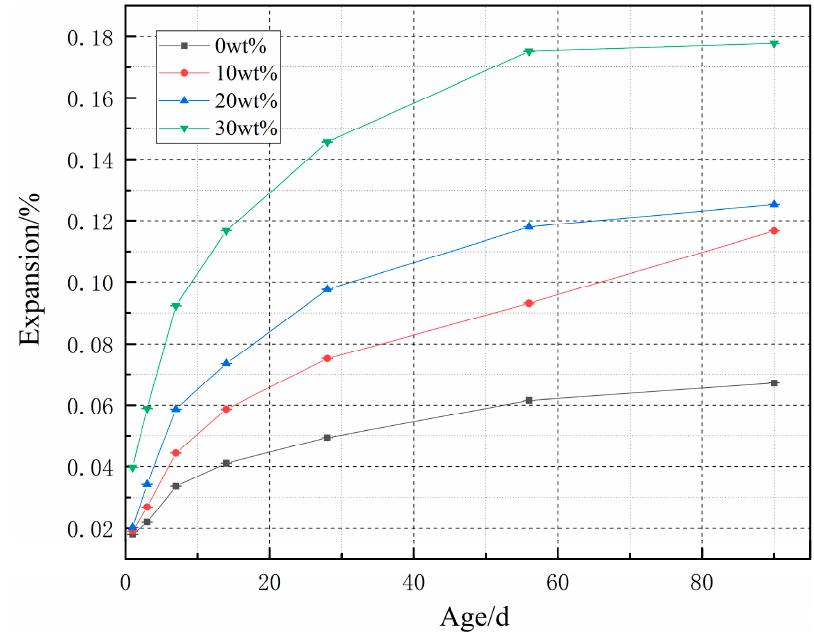
Figure 4. Expansion change data of pure paste samples with different dosage.